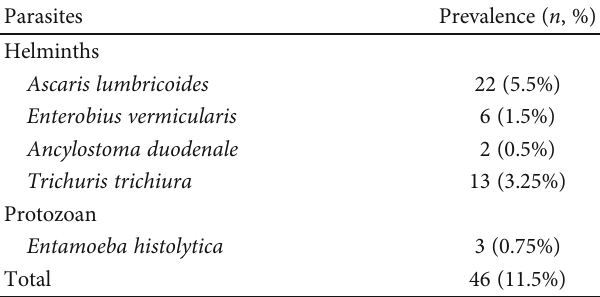
Table 1: Prevalence of